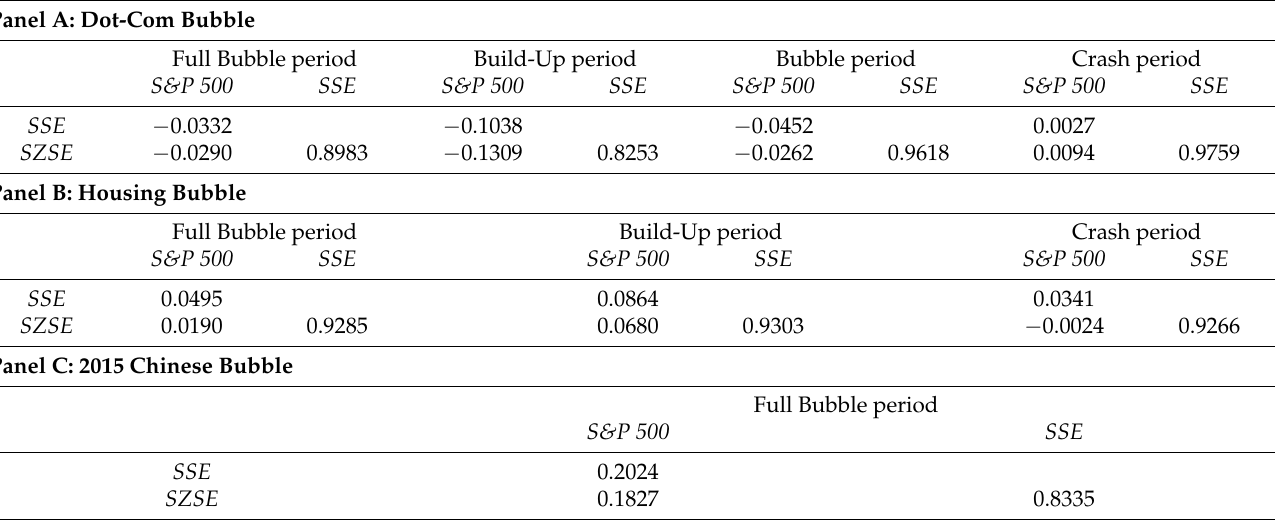
Table 2. Correlations between Return Series.